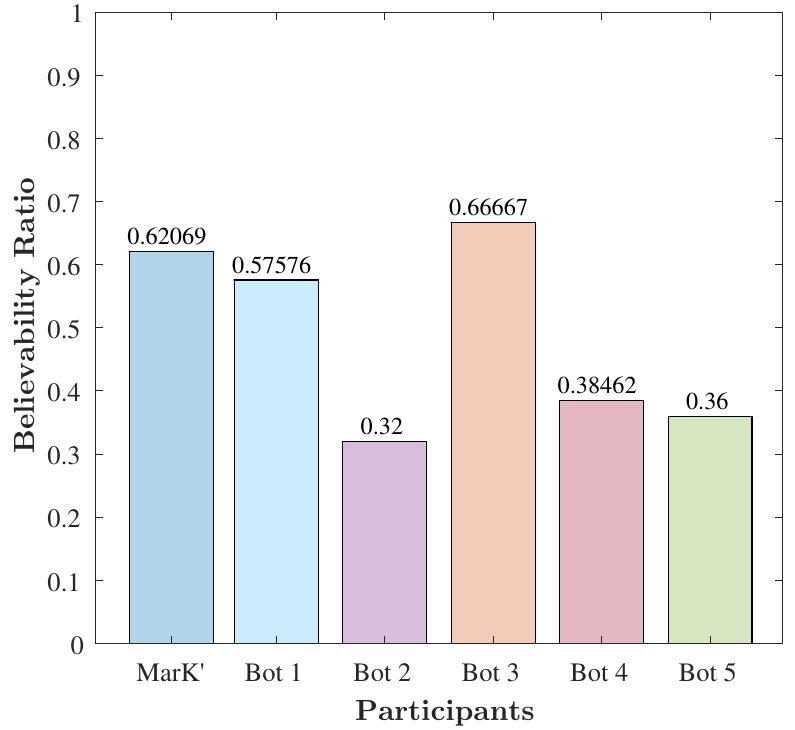
Figure 8. Computed human-likeness ratios for the third-person Turing test for